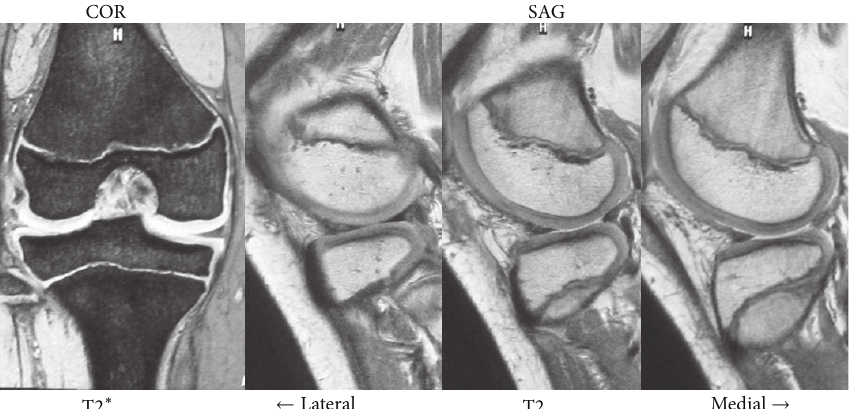
Figure 2: Magnetic resonance imaging (MRI), showing a defect in part of the load-bearing surface of the tibial lateral condyle articular cartilage.